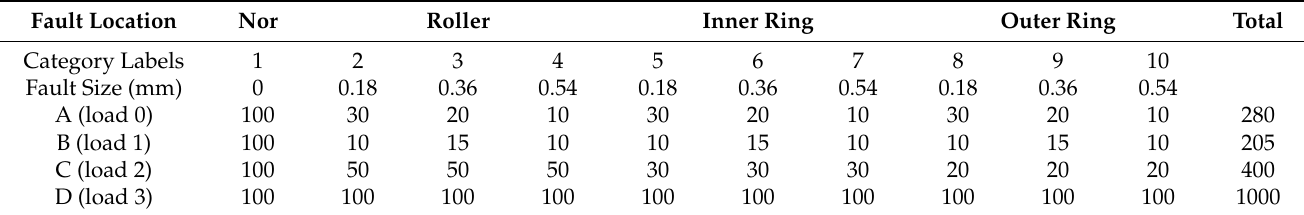
Table 2. Rolling bearing dataset with sample class imbalance distribution. Fault Location Nor Roller Inner Ring Outer Ring